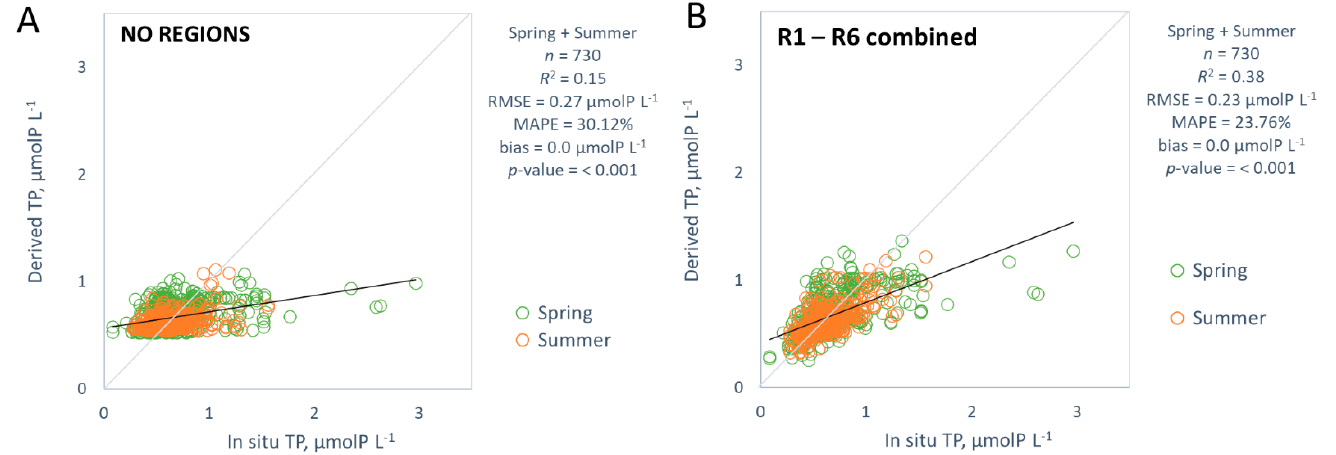
Figure 6. The comparison of the derived total phosphorus (TP, µ molP L -1 ) with the in situ TP: ( A ) the derived TP is based on all the stations with no regions; ( B ) the TP is derived in all the regions (R1–R6) separately. The statistics on the right and the linear regression trendline (black line) are combined periods of spring (April to June: green rings) and summer (July to September: orange rings).